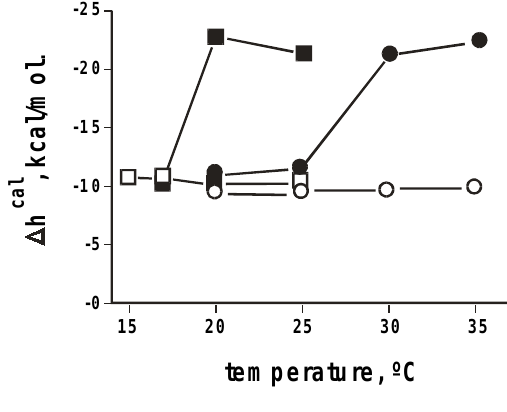
Fig. 3 – Effect of gradient and temperature on ofATP